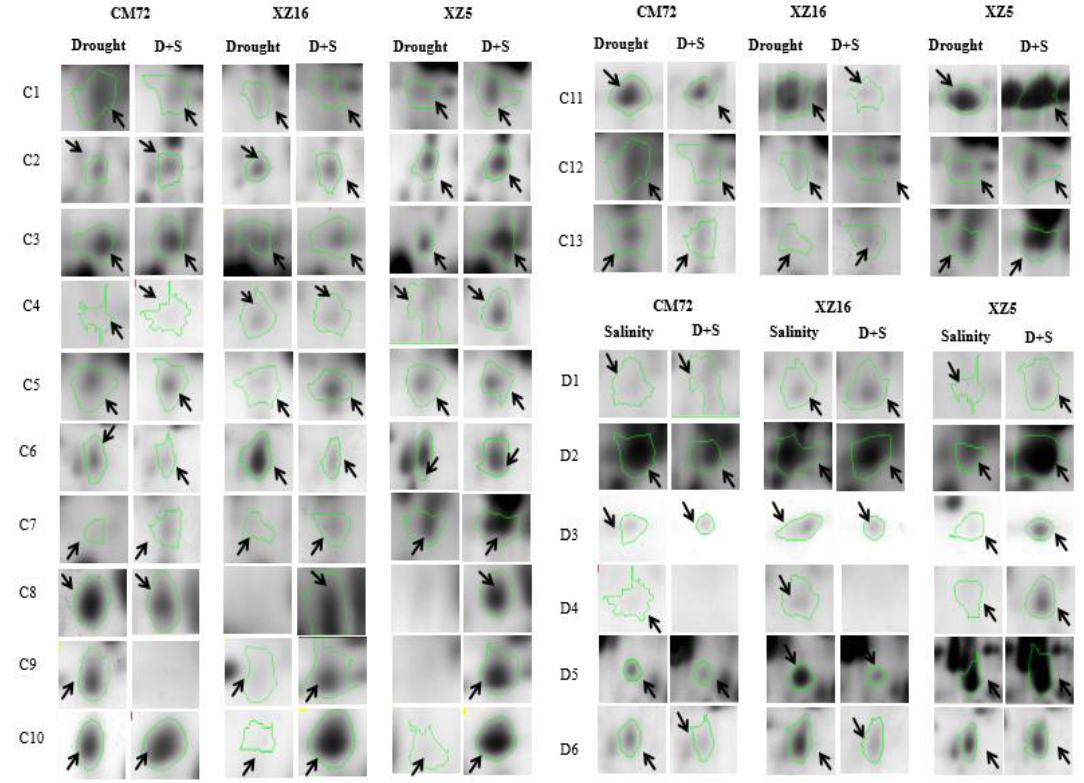
Figure 2. ‘Spot view’ of the abundance of differentially expressed proteins (indicated with green circles) in the leaves of three barley genotypes XZ5, XZ16, and CM72 under drought stress, and salinity stress (200 mM NaCl) and D+S stress conditions. Protein spot IDs refer to numbers in Figure 1c,d and Tables 1 and 2.